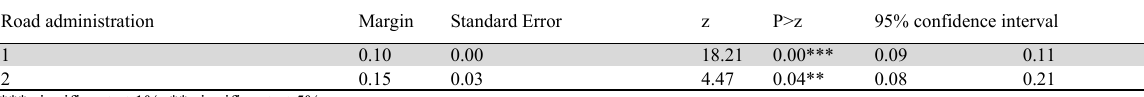
Accident probabilities with deaths by road administration Road administration